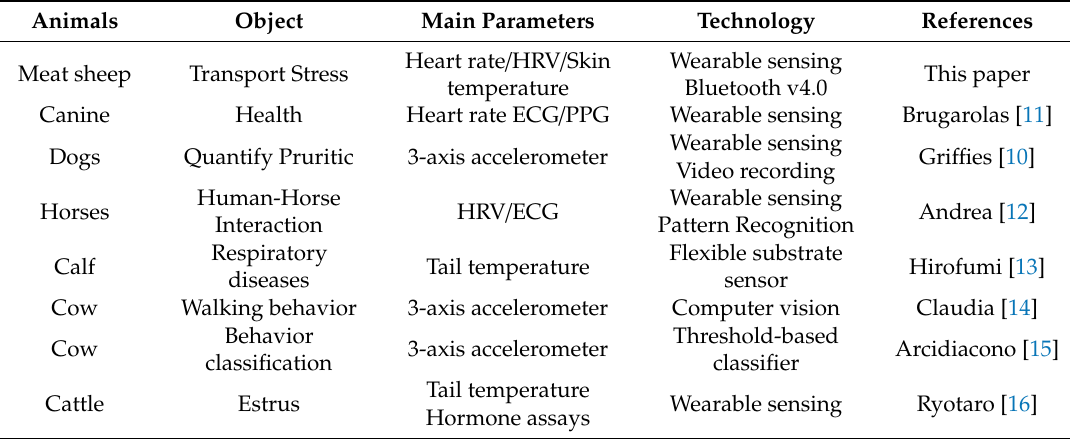
Table 1. Comparing the present research with related